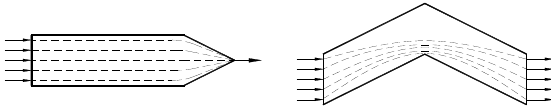
Figure 8. Stress flow characteristics.